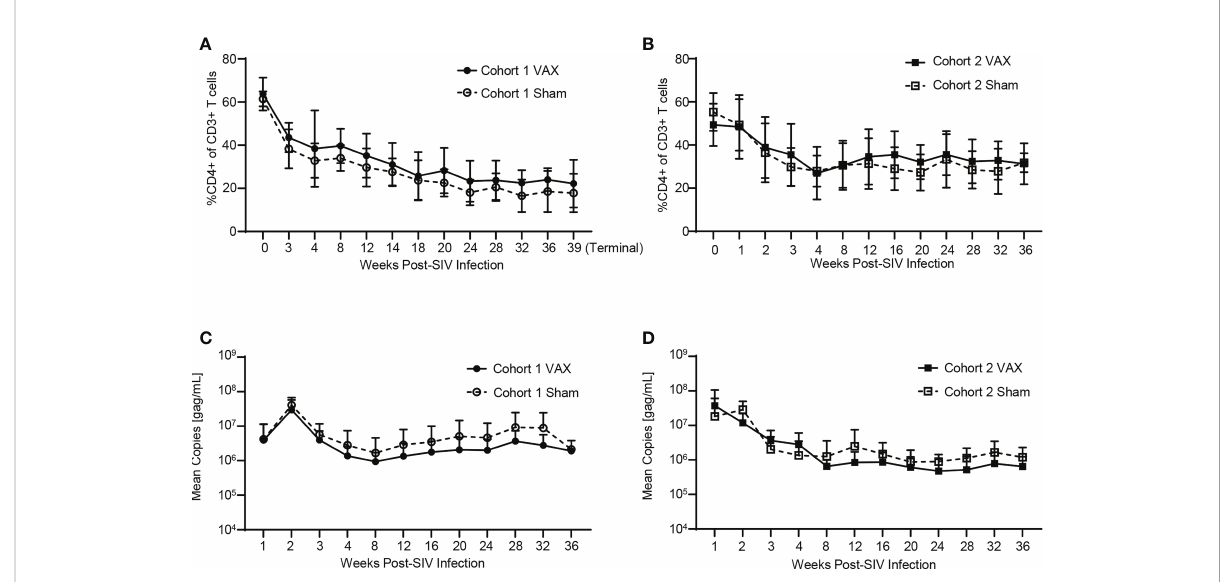
FIGURE 2 Evaluation of peripheral blood CD4+ T cells and viral load throughout SIV-infection and therapeutic boosting with a -GC+KEX1 Frequencies of peripheral blood CD4+ T cells (A, B) and viral load (C, D) from Cohort 1 and Cohort 2 comparing vaccinated (VAX) and sham vaccinated (Sham) animals. Data represents the mean ± SD. Statistical signi fi cance between VAX and Sham cohorts over time was evaluated by repeated measures mixed modeling analysis using the Geisser-Greenhouse model correction and Sidak correction for multiple